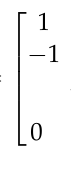
(cid:2) (cid:3) T . The second and third columns 0 0 1 1